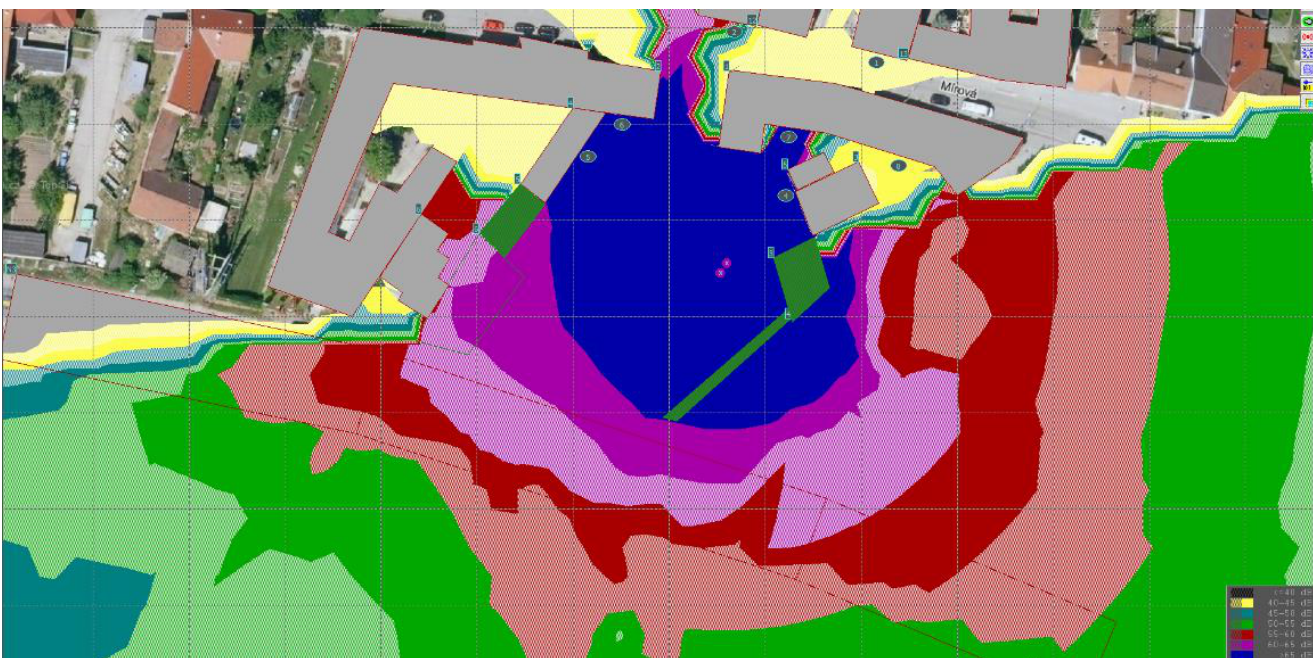
Table 17. Expected sources of construction noise.